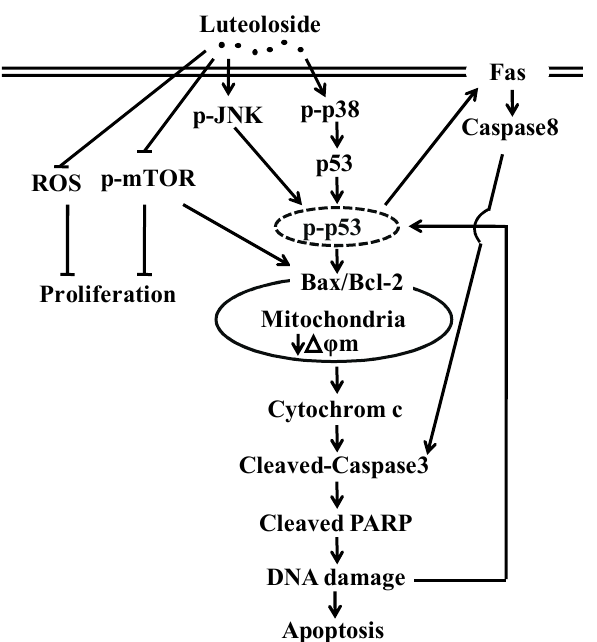
Figure 9. The possible signaling pathways for luteoloside-induced proliferation inhibition and apoptosis in Hela cells. ROS: Reactive oxygen species; PARP: Poly (ADP-ribose) polymerase; “ ⊥ ”: Inhibitory effect; “ ↓ ”: Stimulatory effect.